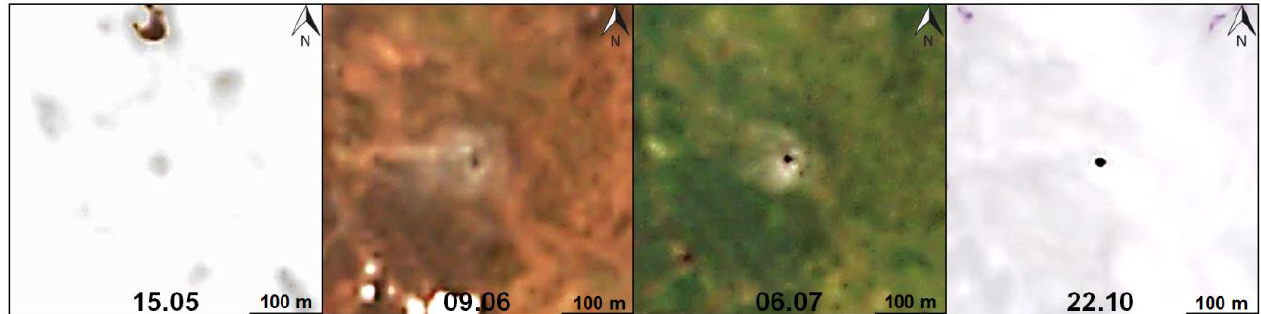
Figure 8. Images of the C17 object from Sentinel-2A (June 9 and July 6) and Sentinel-2B (May 15, October 22) satellites in 2020.